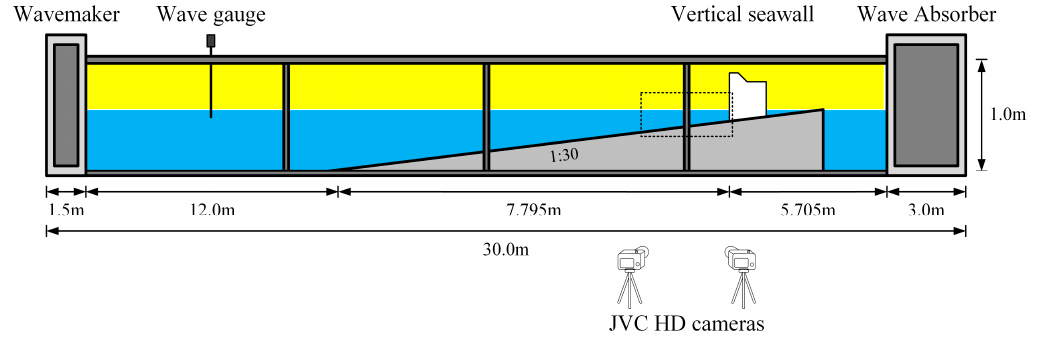
Figure 2. Experimental setup.